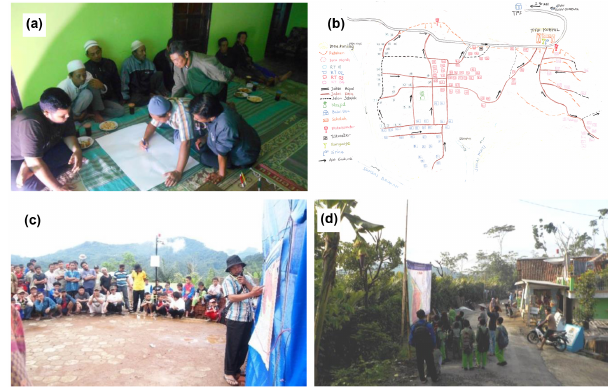
Figure 4. Communication and dissemination process with the local community. (a) The disaster preparedness and response team draw a community hazard map. (b) The newly developed community map is shown. (c) The team coordinator is explaining the map to the community. (d) Students read the evacuation